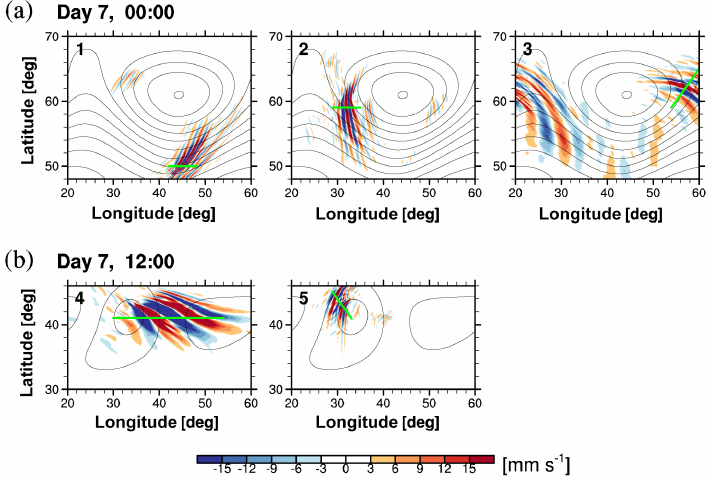
Figure 5. w (cid:48) at z = 8km (shading) (a) at 00:00UTC on day 7, reconstructed from the three spectral domains (1–3) indicated in Fig. 4a, and (b) at 12:00UTC on day 7, from the two spectral domains (4 and 5) in Fig. 4b. The background pressure at 250m is superimposed (contour) with intervals of 8hPa. The green lines indicate the axes along which the vertical cross sections are shown in Fig. 11.